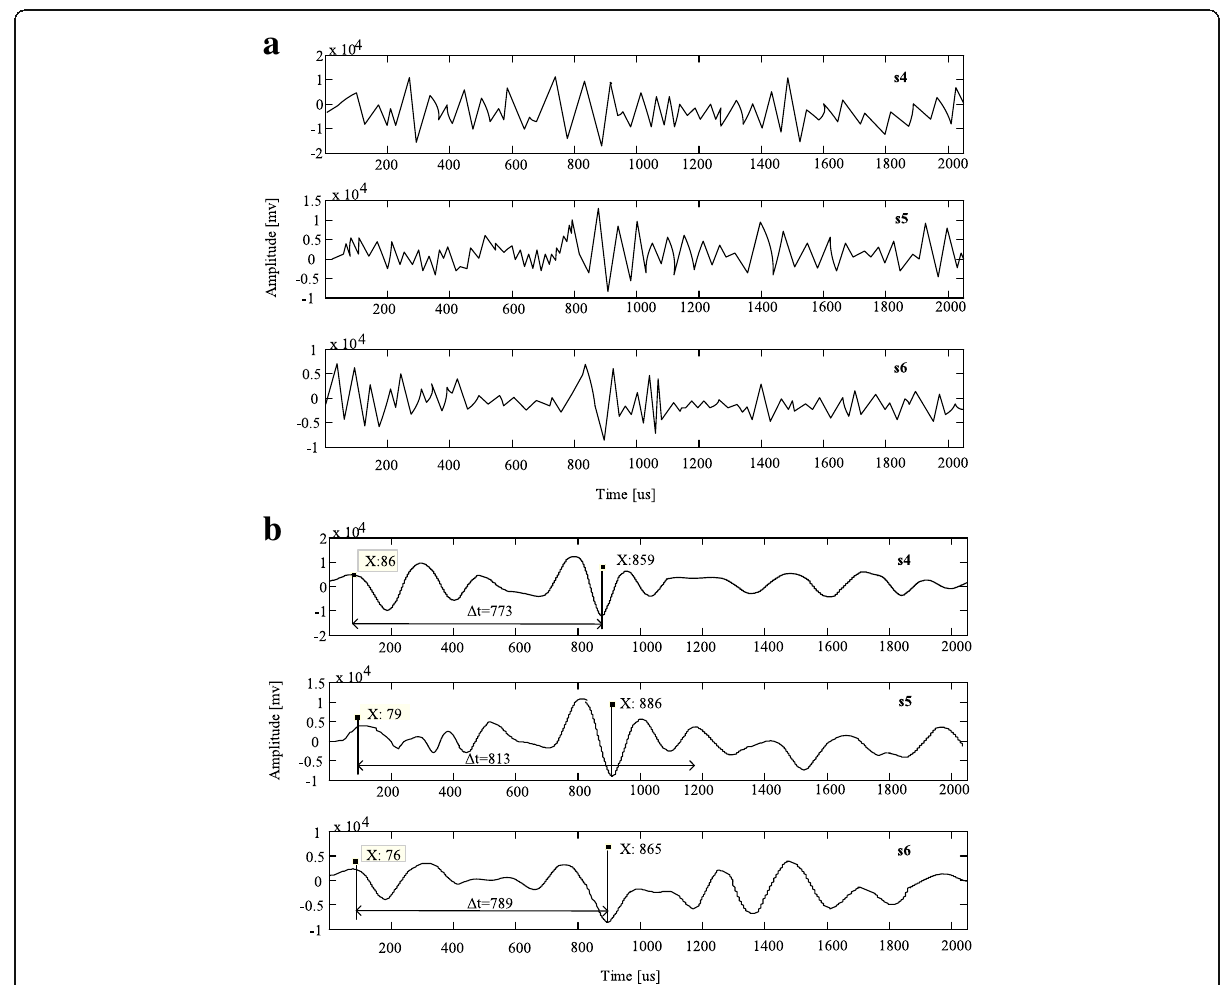
Fig. 7 Waveform diagram of low-frequency analysis for samples 4#, 5#, and 6#. ( a ) Original signal of sample 4#, 5#, and 6#. ( b ) Low-frequency decomposition by 5 scale of 4#, 5#, and 6#